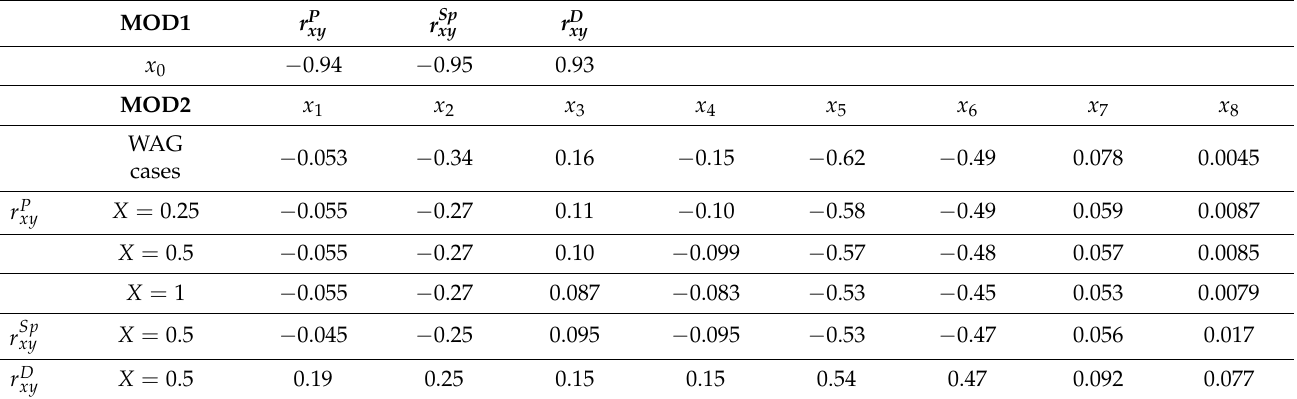
Table 3. Pearson, Spearman and Distance correlation coefficients r xy evaluated for the total dataset between RF and the involved input parameters for MOD1 and